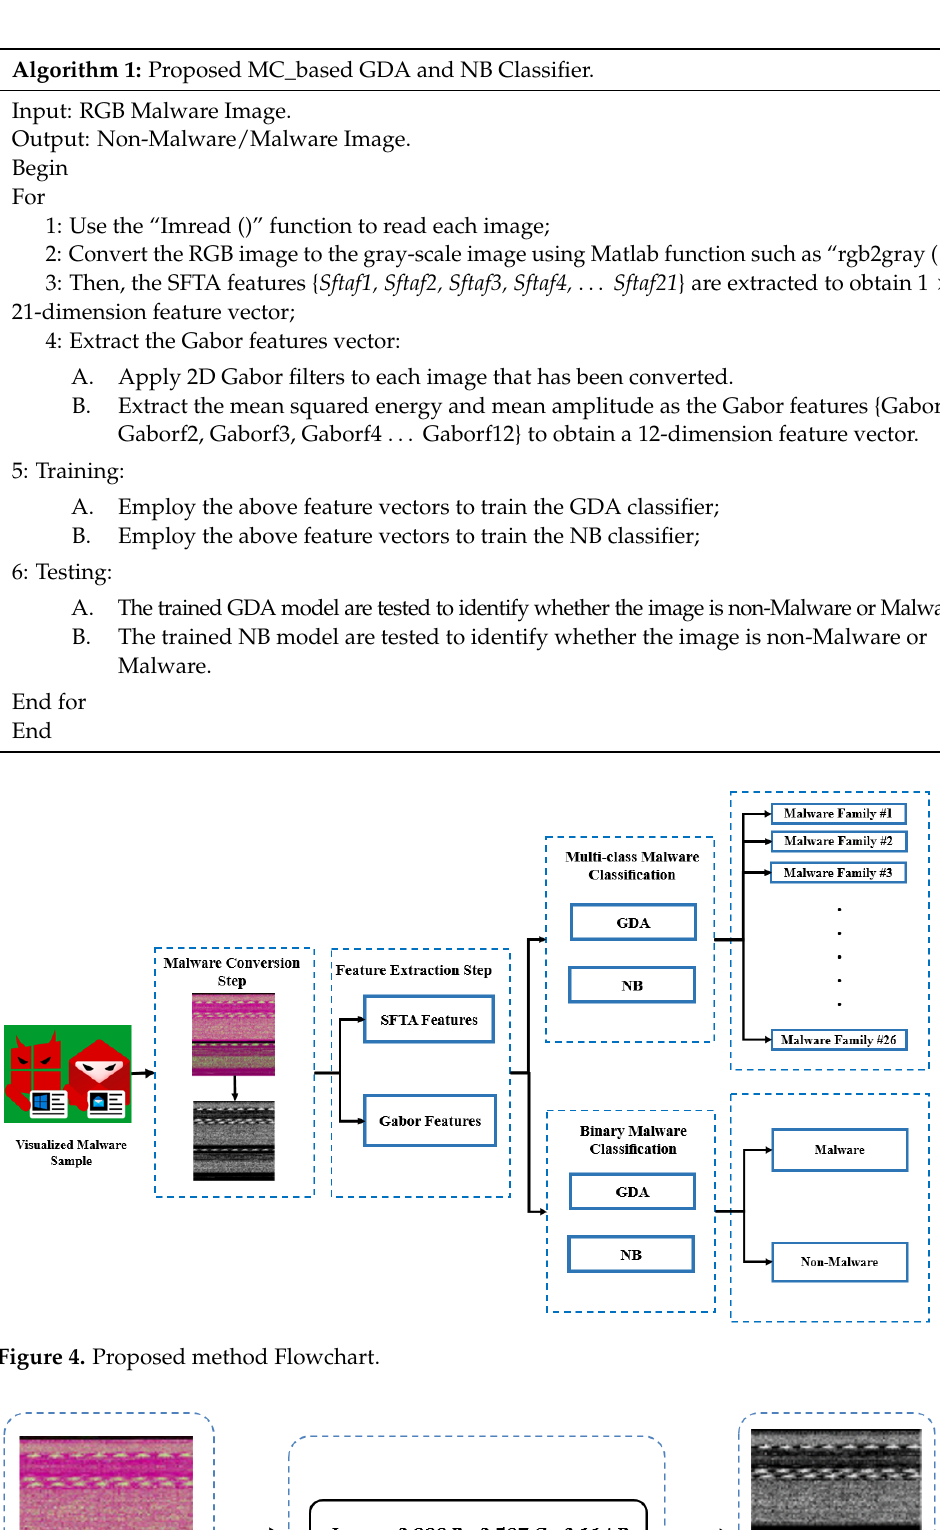
Algorithm 1: Proposed MC_based GDA and NB Classifier.